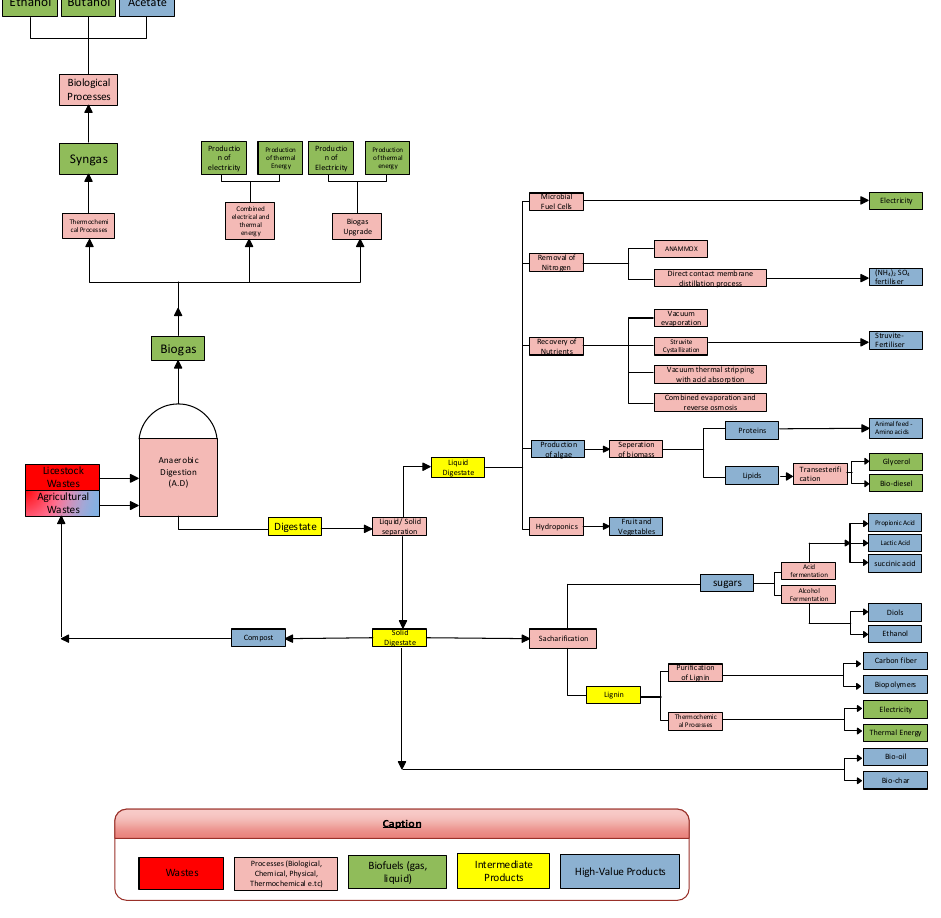
Figure 2. Process flowchart of a biorefinery plant [39–43]. Table 4. Waste, intermediate products, biofuels, and high value products in a biorefinery [38–42]. Description